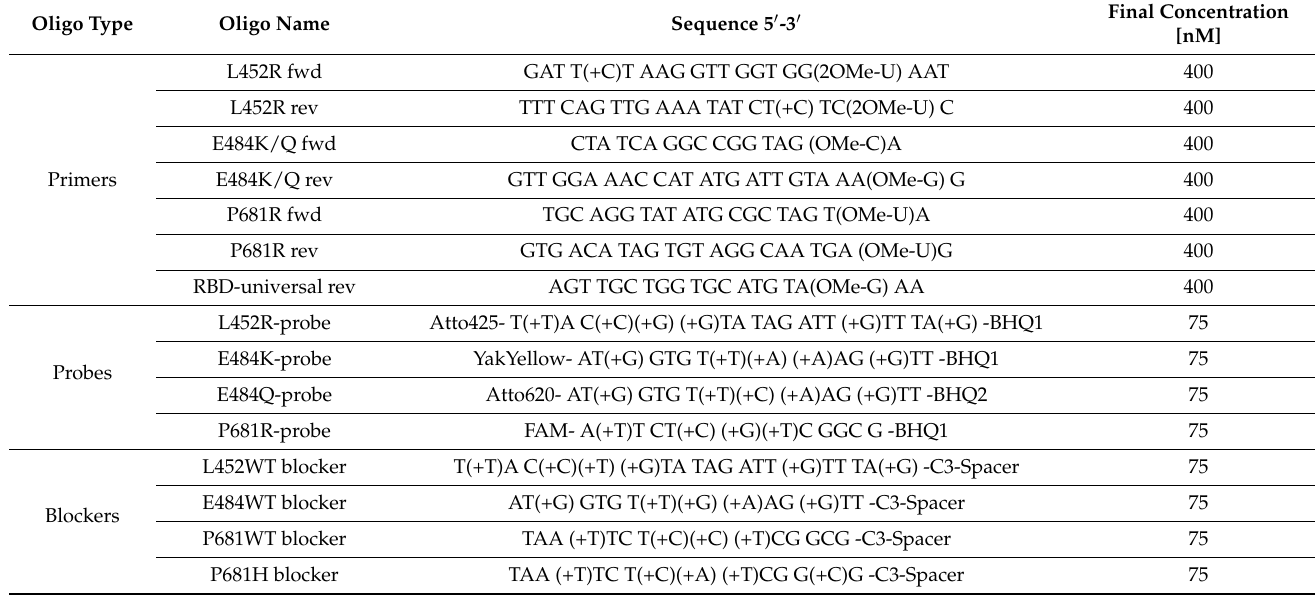
Table 1. Primers and probes were custom made by Ella Biotech GmbH (Martinsried, Germany), biomers.net GmbH (Ulm, Germany) and IDT (Coralville, IA, USA). Indicated final concentrations refer to concentrations within the final reaction mix. OMe-N, 2 (cid:48) O-methyl-RNA base. (+N), Locked nucleic acid